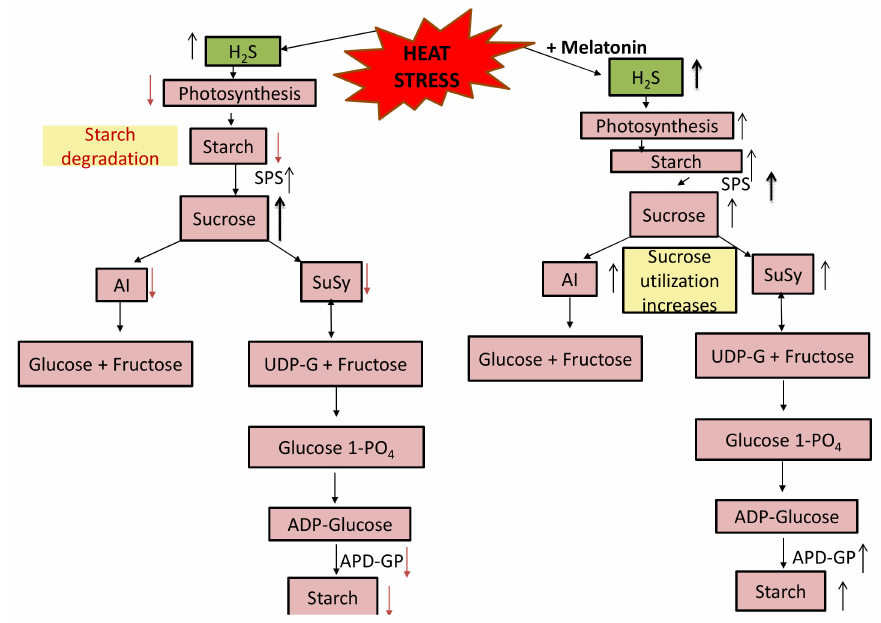
Figure 9. Influence of heat stress and melatonin on carbohydrate metabolism. Red arrow shows de- crease and black arrow shows increase. Double headed arrow shows regulation in both the direction. Black thick arrow shows more increase. SPS, sucrose phosphate synthase; ADP-GP, ADP-Glucose phosphorylase; AI, acid invertase; SuSy, sucrose synthase; UDP-G, uridine diphosphate